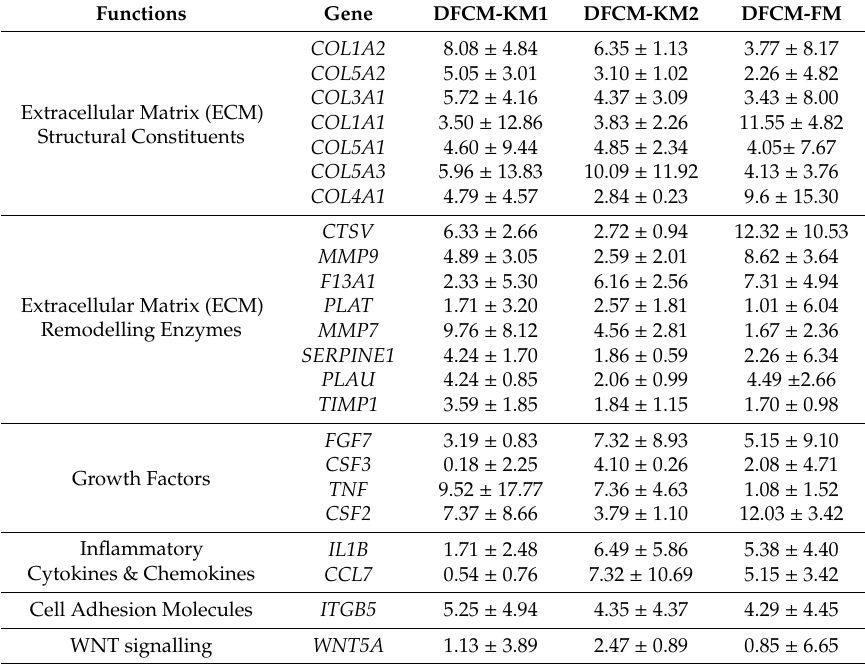
Table 2. Up-regulated genes in DFCM groups as compared to KM1 group (control). Functions